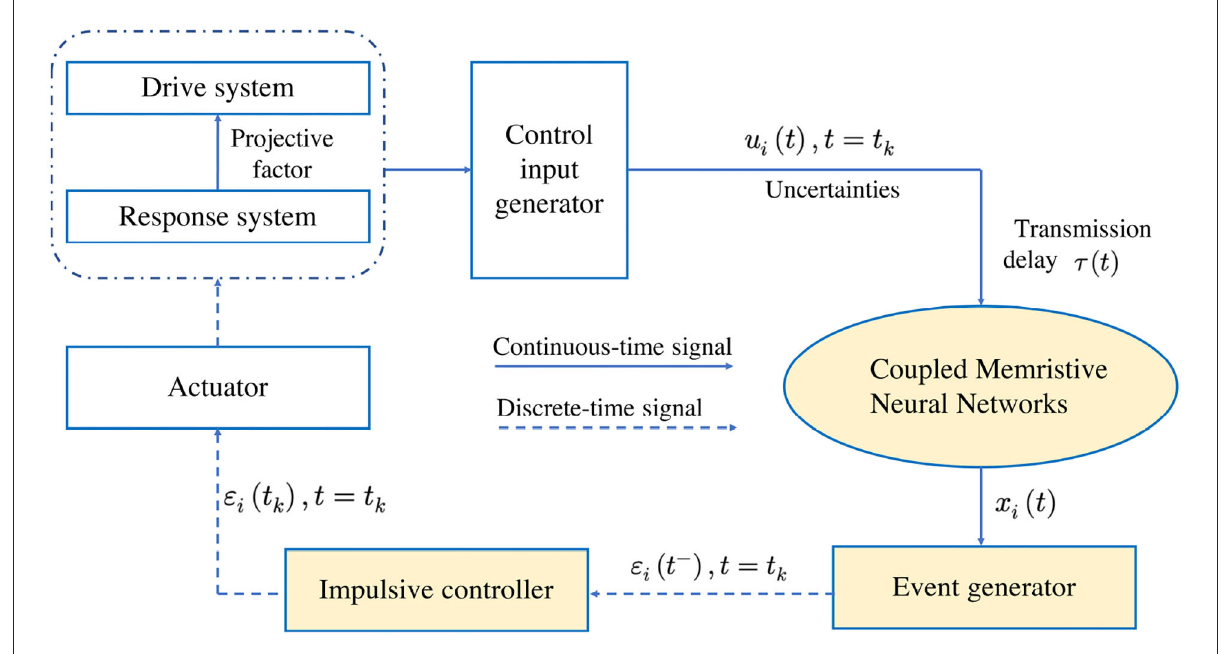
FIGURE2 The event-triggered scheme for the proposed couple